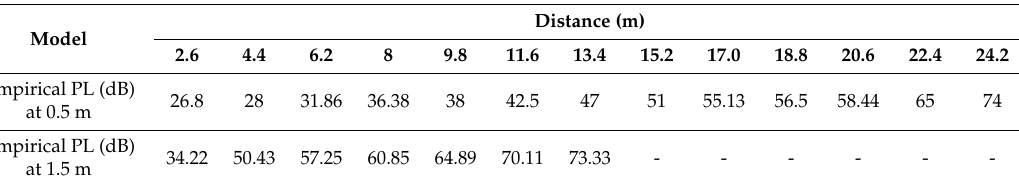
Table 2. Total attenuation of the propagation of the radio wave in the presence of vegetation with nodes at 0.5 m and 1.5 m from the ground.